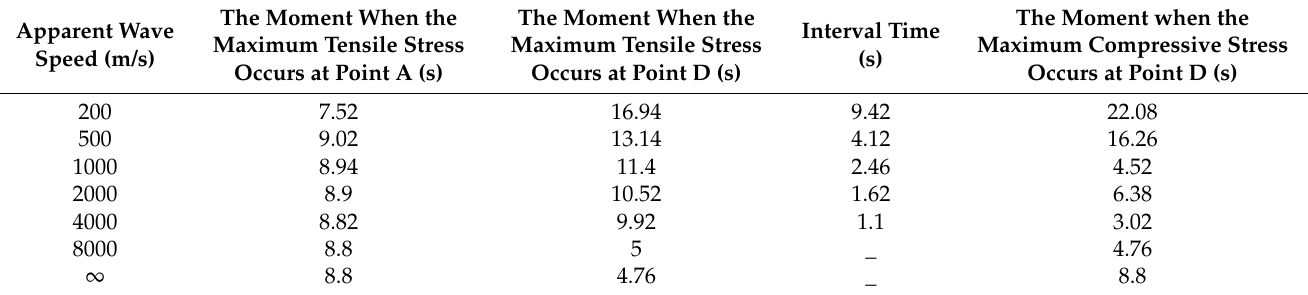
Figure 17. Stress–time-history curves of rails at points A and D under consistent excitation. Table 6. The moment when the maximum stress occurs at points A and D.